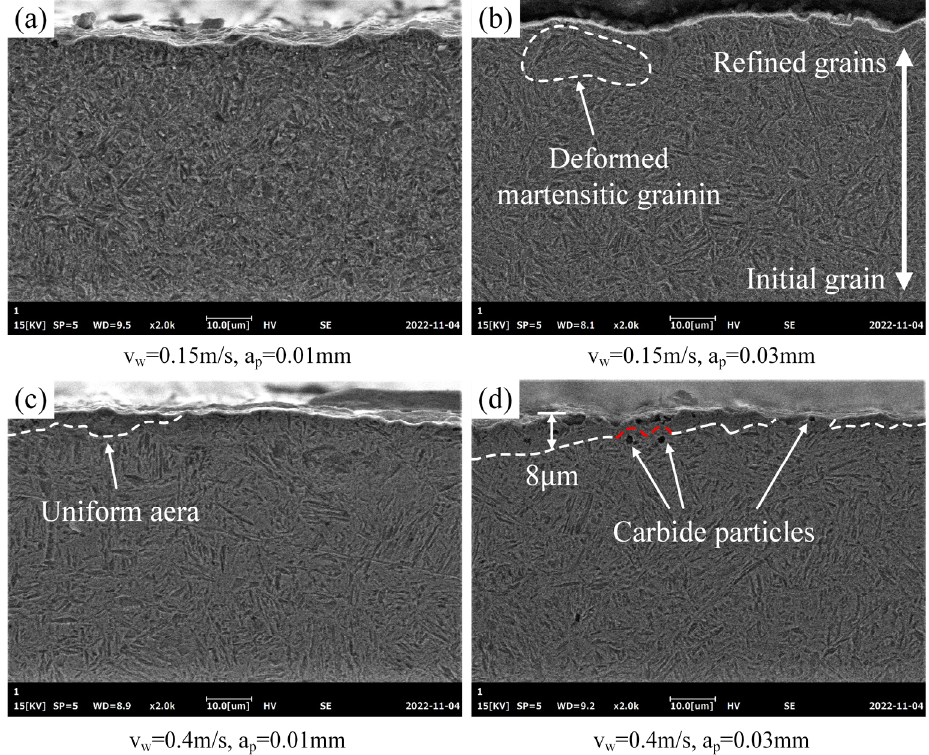
Figure 12. Microstructure of the machined surface layer under the parameters of ( a ) 0.15 m/s, 0.01 mm; ( b ) 0.15 m/s, ap = 0.03 mm; ( c ) 0.4 m/s, 0.01 mm; and ( d ) 0.4 m/s, 0.03 mm.